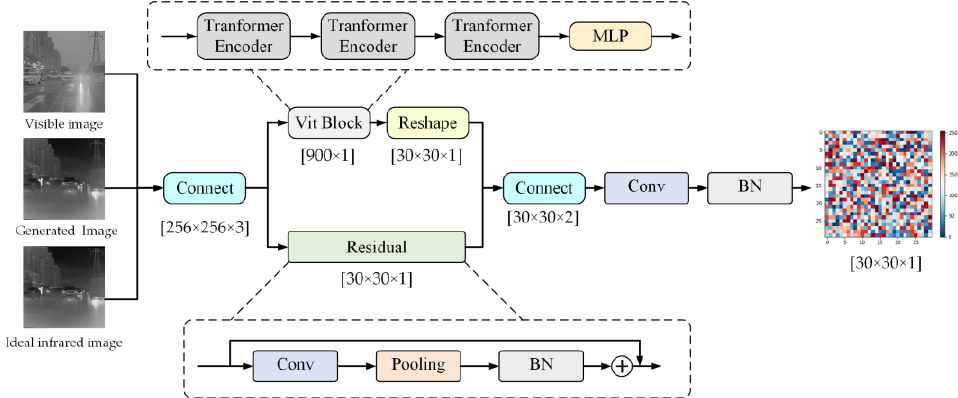
Figure 8. Structure of the Vit-Discriminator.